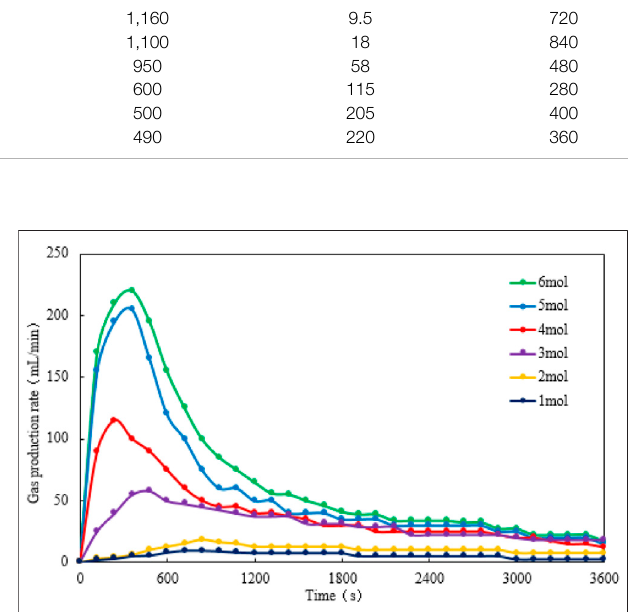
FIGURE 7 | Cumulative gas production vs. time at different HCl concentrations.